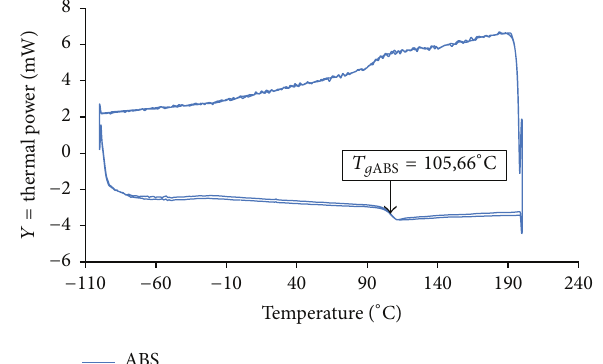
Figure 2: DSC curve of the copolymer ABS